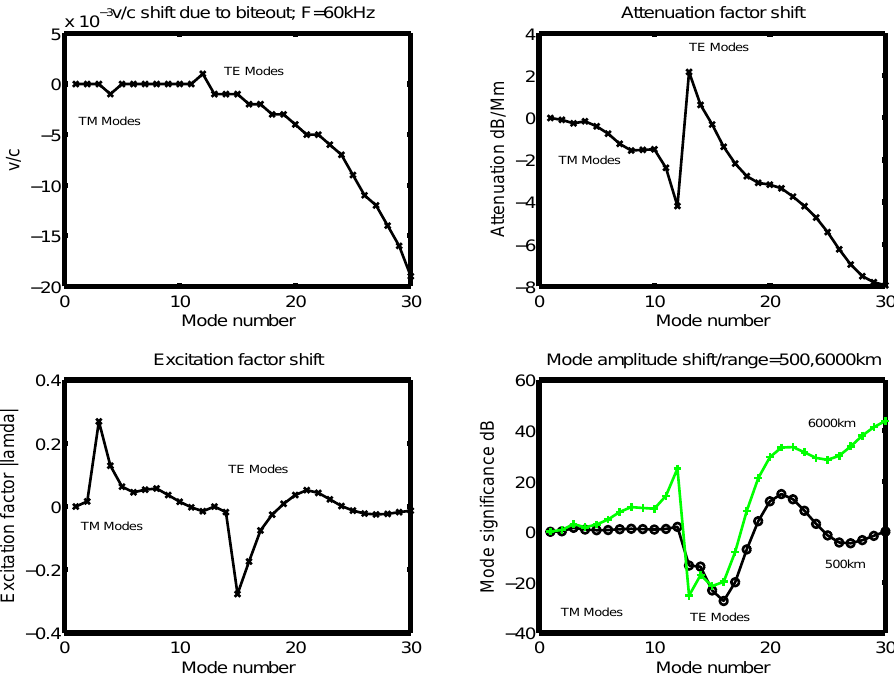
Fig. 7. Shift in modal parameters due to biteout at f =60kHz. Key features are the decreased attenuation and increased excitation of TM modes and decreased phase velocity of TE